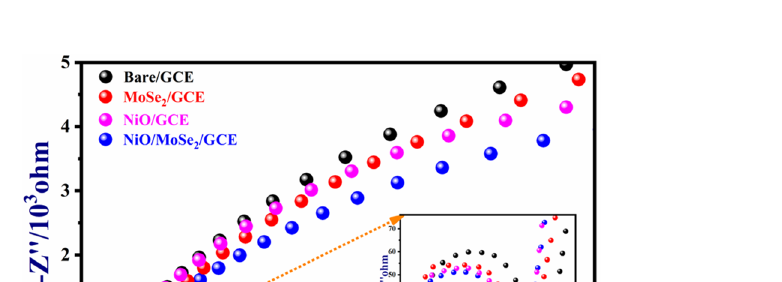
Figure 5. XPS spectra of the NiO/MoSe 2 nanocomposite were recorded: ( a ) Mo 3 d , ( b ) Se 3 d , ( c ) Ni 2 p and ( d ) O 1 s .